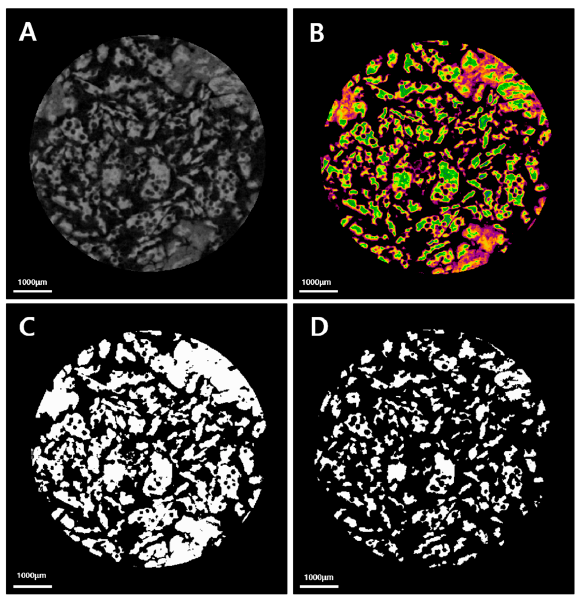
Figure 13. Micro-computed tomographic (CT) images of regions of interest. ( A ) Reconstructed image; ( B ) Color image (yellow and green-bone graft material and orange and purple-new bone); ( C ) Total bone (bone graft material and new bone) image; ( D ) Bone graft material image.